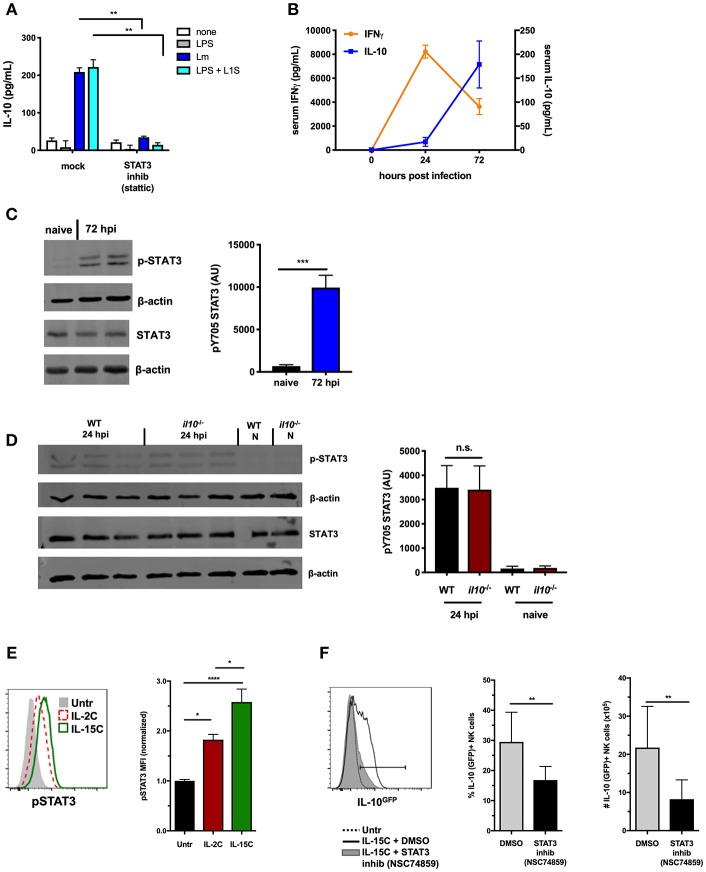
STAT3 activation is associated with NK cell IL-10-production. (A) Supernatant IL-10 at 72 h after co-culture with B6. il10−/− BMDC. BMDC were infected with Lm or stimulated with LPS + L1S for 1 h before addition of purified WT NK cells ± STAT3 inhibitor (Stattic). (B) Serum IFNγ and IL-10 at indicated time points from WT mice infected with 104 Lm i.v. (C) Immunoblot detection of p-STAT3 (Y705) and total STAT3 from lysates of purified NK cells isolated from WT naive mice and 72 hpi with 104 Lm i.v. Densitometry quantification shown as Arbitrary Units (AU) normalized to β-actin loading controls. (D) Detection of p-STAT3 (Y705) and total STAT3 from NK cells isolated from naïve (N) or 24 hpi with 104 Lm i.v. WT and B6. il10−/− mice. (E) Expression of p-STAT3 measured by flow cytometry in splenic NK cells (NK1.1+NKp46+TCRβ-) from B6. il10−/− untreated mice compared to mice treated (on d0 and d2) with IL-2C or IL-15C i.v. Splenocytes were harvested 1 h following d2 treatment. Histogram and mean fluorescent intensity (MFI) are shown. MFI values normalized relative to naive mice. (F) Percentage and number of IL-10-GFP+ NK cells (NK1.1+NKp46+TCRβ-) from IL-10-GFP reporter mice treated with IL-15C i.v. on d0 and d2 and three treatments of either STAT3 inhibitor (NSC 74859) or DMSO i.p. on d0, d2, and d3. Splenocytes were harvested on d5 for analysis of IL-10-GFP expression. *p < 0.05, **p < 0.01, ***p < 0.001, ****p < 0.0001 as measured by t test.